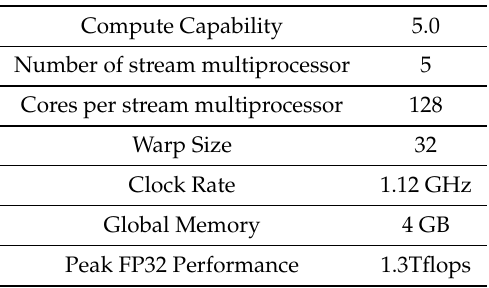
Table 4. The detailed parameters of Quadro K2200.